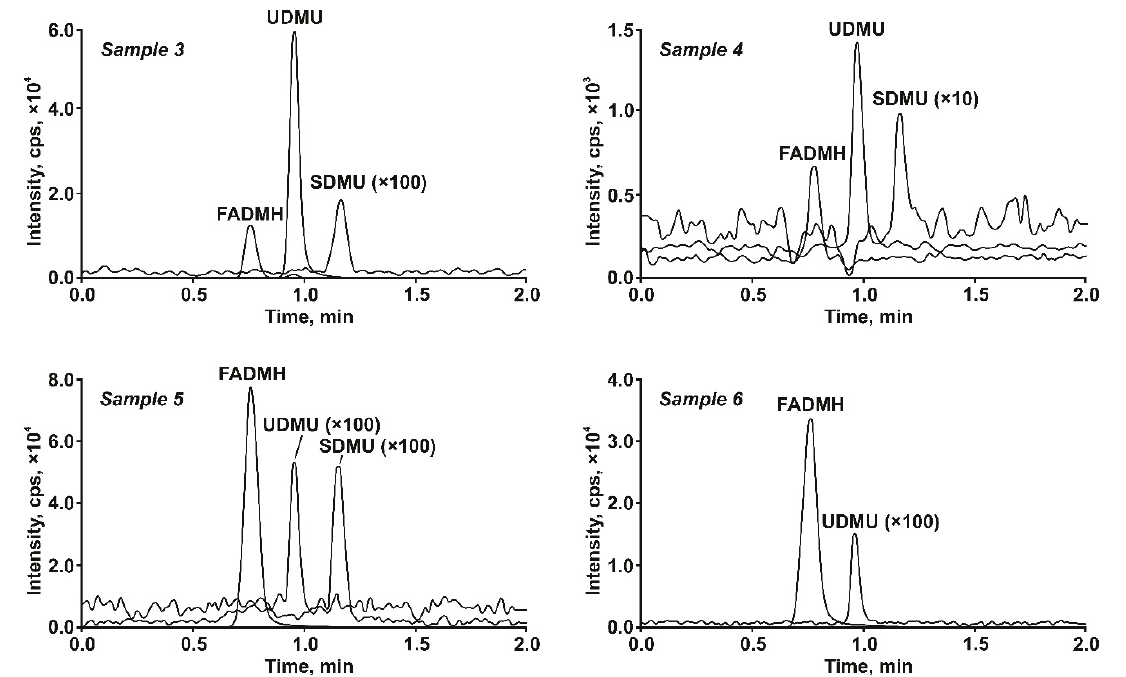
Figure 2. SFC-MS/MS chromatograms of real samples containing UDMH transformation products. Table 5. Measured concentrations (contents) of analytes in real samples of UDMH transformation products. Sample